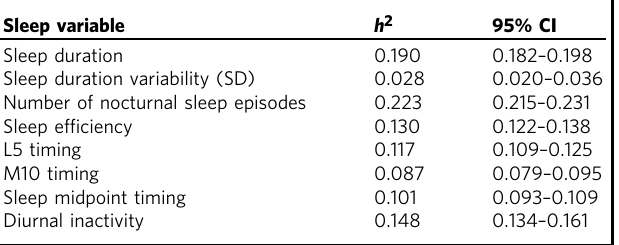
Table 2 Heritability estimates of derived sleep variables from BOLT-REML